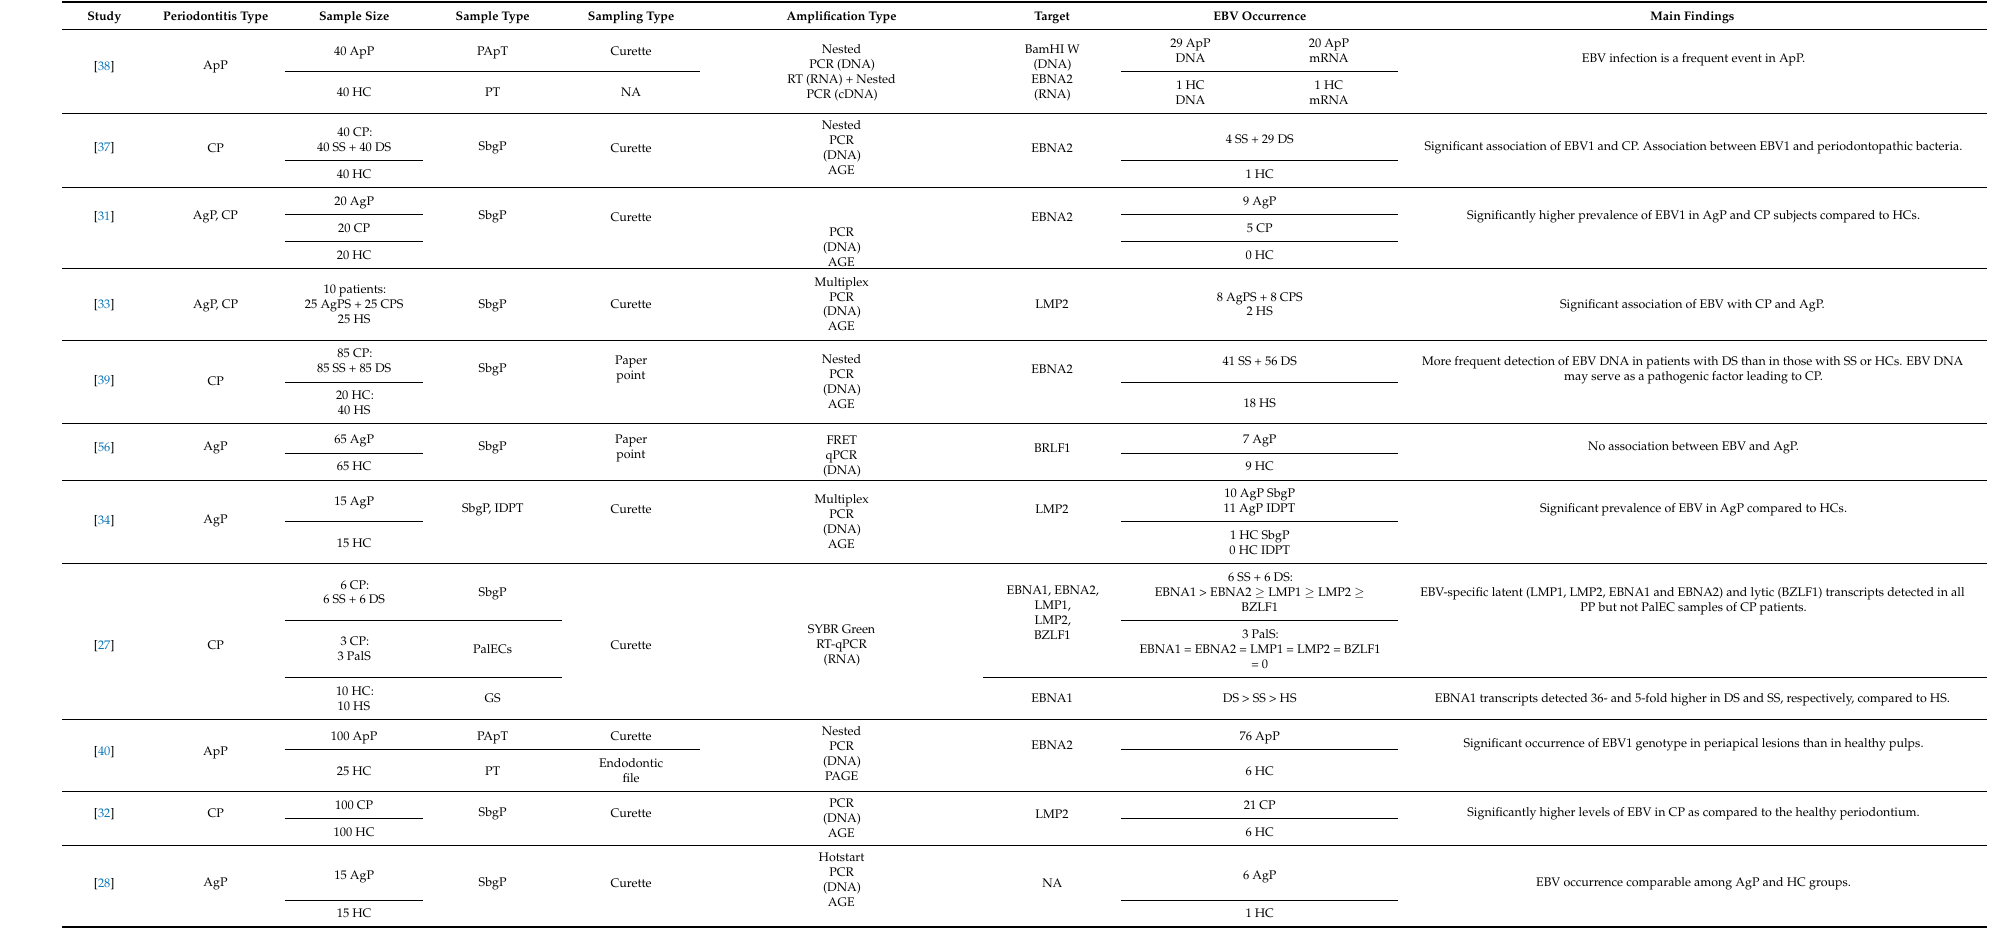
Table 1. Characteristics of the studies using nucleic acid amplification-based detection